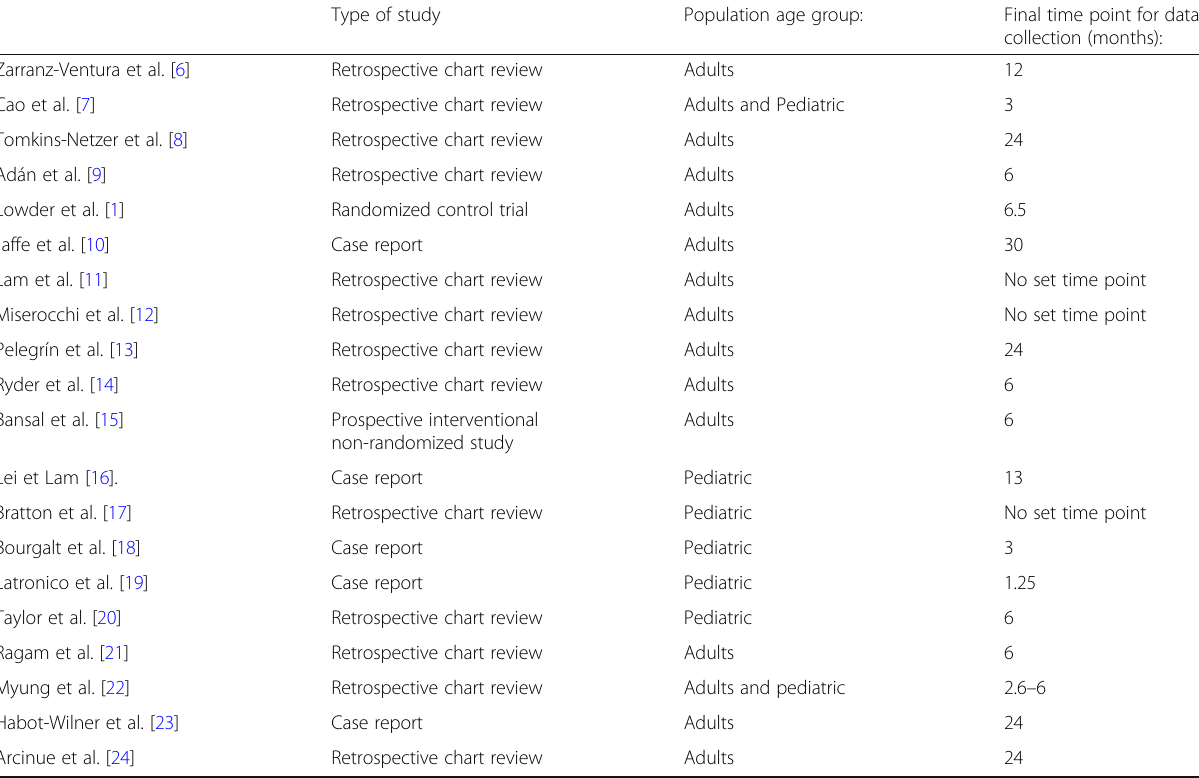
Table 2 Information about the selected studies Type of study Population age group: Final time point for data